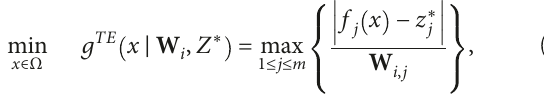
Algorithm 1: Adaptive weight vector